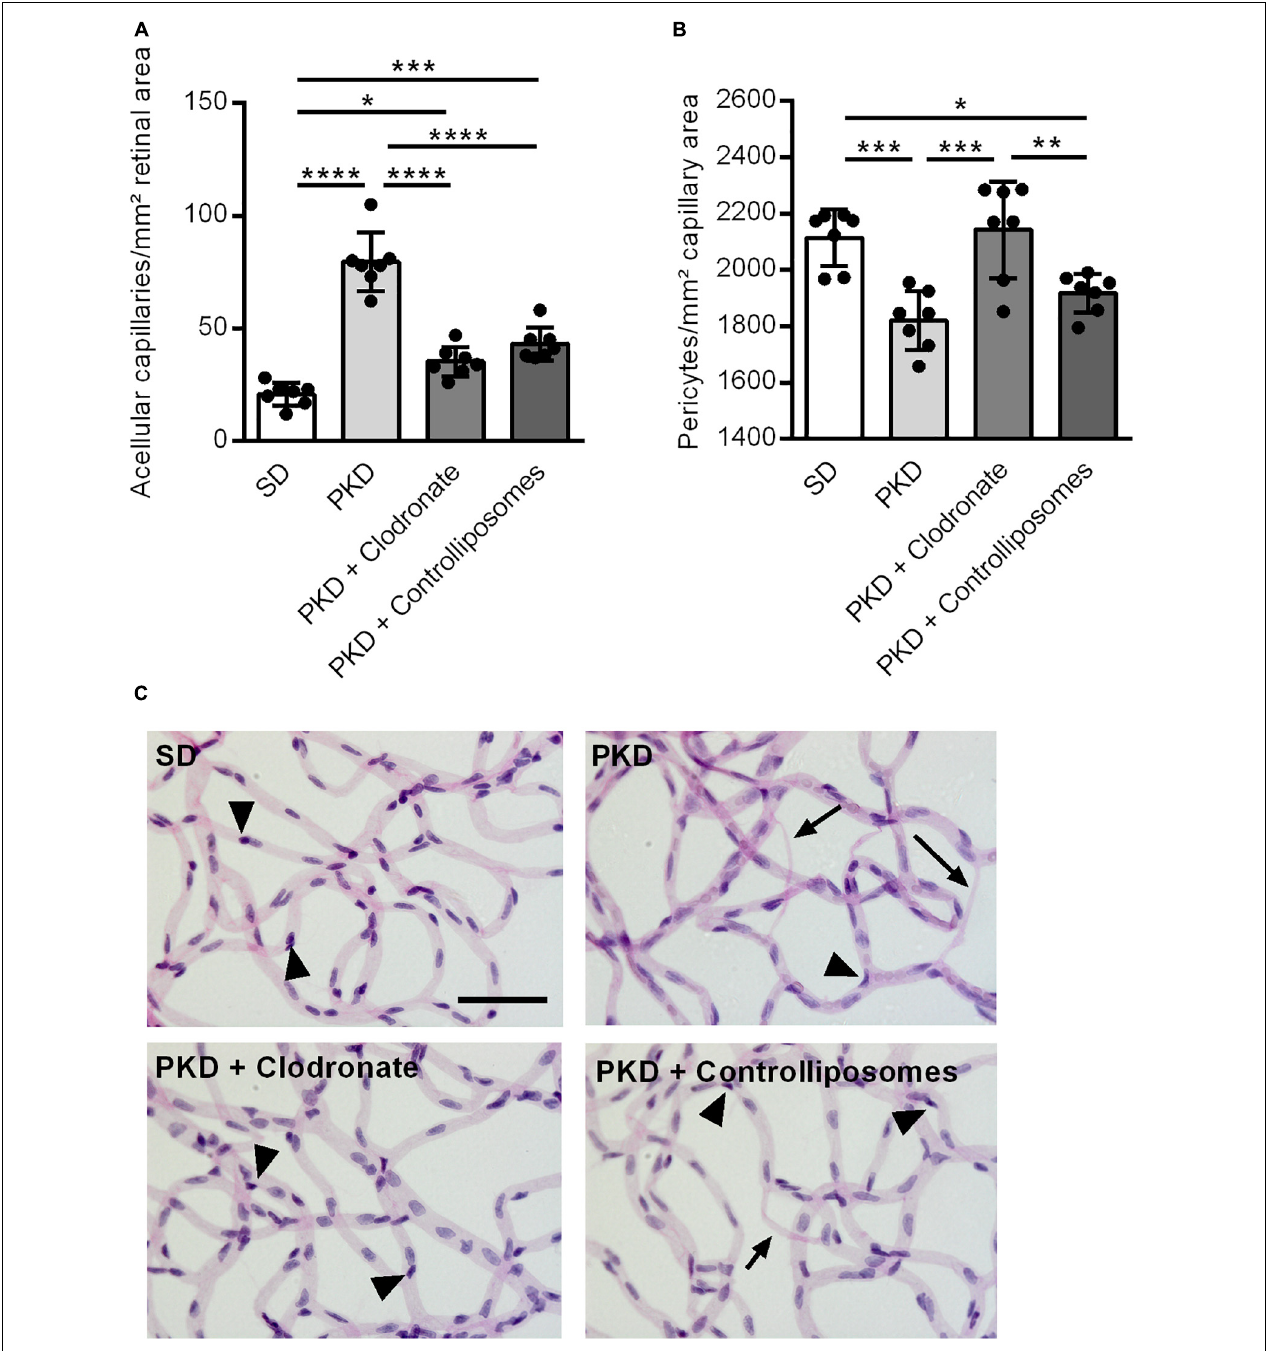
FIGURE 2 | Vasoprotection in clodronate-treated PKD rats. (A) The number of acellular capillaries was significantly increased in PKD compared to SD rats. Upon liposome injection, the formation of acellular capillaries was almost completely prevented. (B) In PKD rats, the number of pericytes was significantly reduced compared to that in SD rats. This was completely prevented in clodronate-treated PKD rats, whereas control liposomes showed no effects on pericyte loss. (C) Representative retinal digest preparations showing acellular capillaries in PKD, PKD + clodronate and PKD + control liposome rats. * p < 0.05, ** p < 0.01, *** p < 0.001, **** p < 0.0001. Arrow = acellular capillary, arrowhead = pericyte. Scale = 50 µ m.